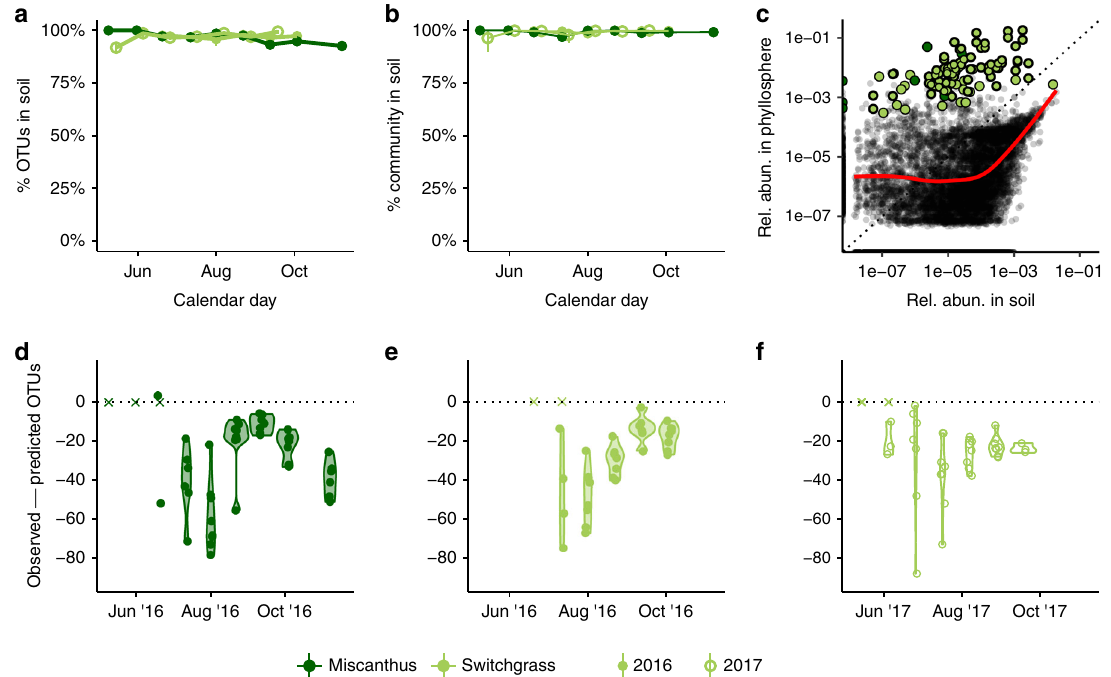
Fig. 3 The majority of phyllosphere taxa were also present in the soil. a Circles represent the mean number of OTUs found in up to eight replicate phyllosphere samples, subsampled to 1000 sequences, for each crop (miscanthus is dark green, fi lled circles, switchgrass is light green) at each time point (2016 is fi lled and 2017 is open). An OTU was considered present in the soil if it occurred at any abundance in any of the 202 unrare fi ed soil samples over two years. b The fractions of the phyllosphere communities present in the soil were even greater when considering the relative abundances of taxa; each circle represents the mean total relative abundance of leaf taxa present in the soil in up to eight replicate phyllosphere samples. c The relative abundances of taxa in pooled phyllosphere samples and pooled soil samples were positively correlated among taxa that were present at greater than 0.01% total abundance in the soil. Each black circle represents an OTU present in both phyllosphere and soil communities; a LOESS smoothing function is shown as a red line. Core members are shown as large green circles. d – f Source-sink models of phyllosphere community assembly from soils. Violin plots show the numbers of observed taxa in the phyllosphere were consistently lower than the richness values predicted by model simulations. The model assumed random increases and decreases in taxon abundances between time points and random immigration from the soil community (see Methods). Each